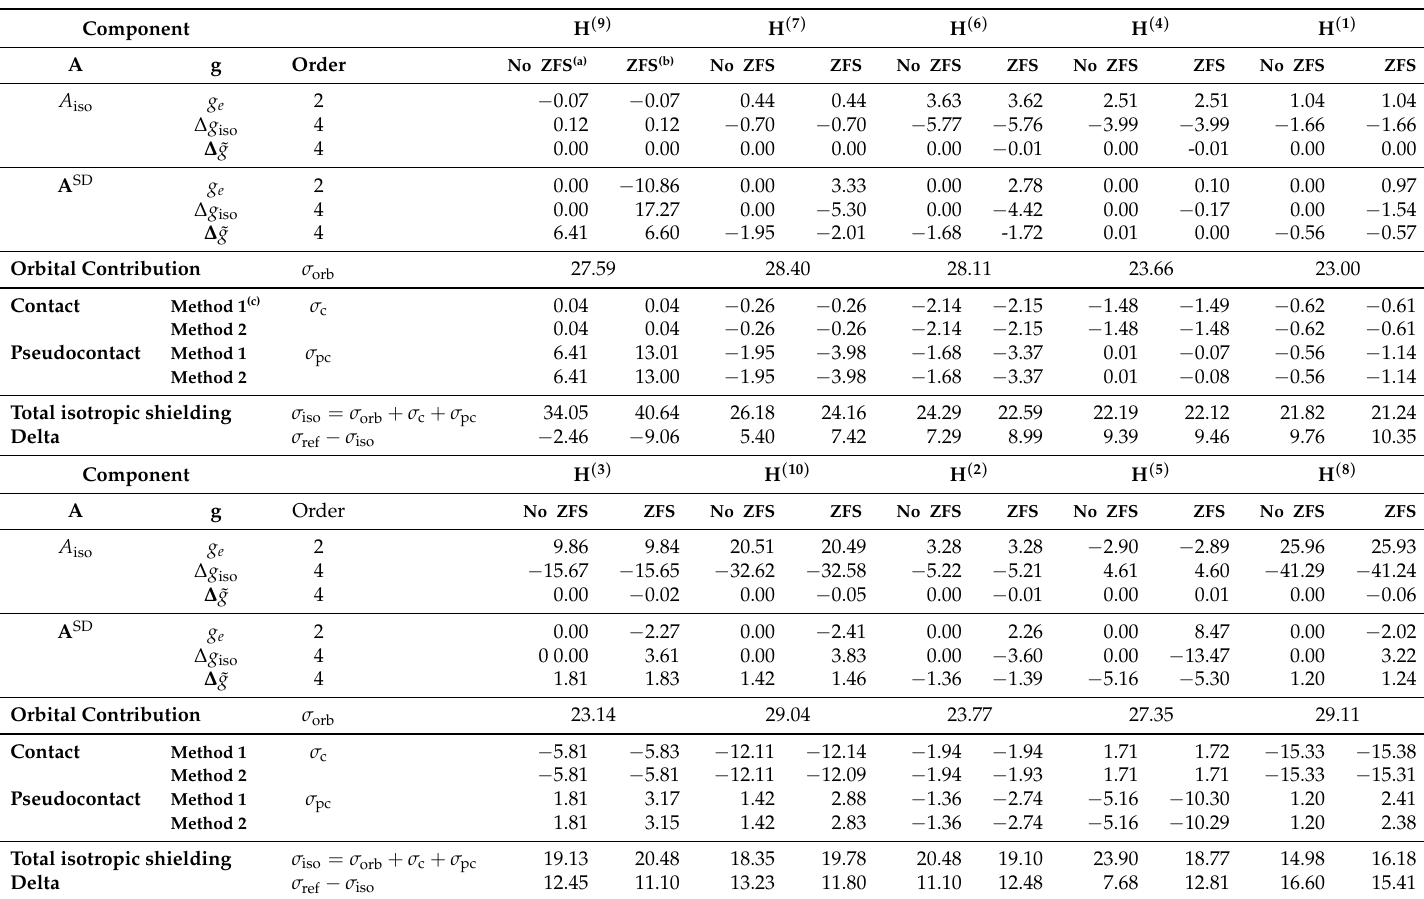
Table 5. Calculated 1 H pNMR shifts of [ NdL py ] 3 + organised in increasing δ . For numbering of protons see Figure 1. The reference chemical shift is 31.58 ppm (TMS) and the temperature is 298.15